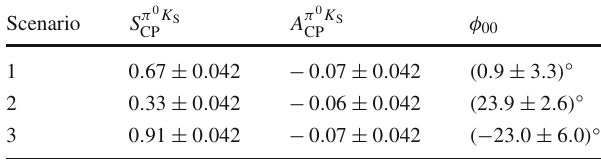
Table 6 Scenarios for future measurements of S π 0 K S